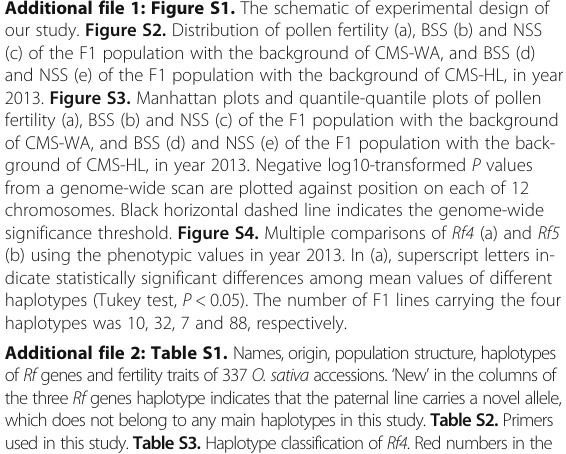
Additional file 1: Figure S1. The schematic of experimental design of our study. Figure S2. Distribution of pollen fertility (a), BSS (b) and NSS (c) of the F1 population with the background of CMS-WA, and BSS (d) and NSS (e) of the F1 population with the background of CMS-HL, in year 2013. Figure S3. Manhattan plots and quantile-quantile plots of pollen fertility (a), BSS (b) and NSS (c) of the F1 population with the background of CMS-WA, and BSS (d) and NSS (e) of the F1 population with the back- ground of CMS-HL, in year 2013. Negative log10-transformed P values from a genome-wide scan are plotted against position on each of 12 chromosomes. Black horizontal dashed line indicates the genome-wide significance threshold. Figure S4. Multiple comparisons of Rf4 (a) and Rf5 (b) using the phenotypic values in year 2013. In (a), superscript letters in- dicate statistically significant differences among mean values of different haplotypes (Tukey test, P < 0.05). The number of F1 lines carrying the four haplotypes was 10, 32, 7 and 88, respectively. Additional file 2: Table S1. Names, origin, population structure, haplotypes of Rf genes and fertility traits of 337 O. sativa accessions. ‘ New ’ in the columns of the three Rf genes haplotype indicates that the paternal line carries a novel allele, which does not belong to any main haplotypes in this study. Table S2. Primers used in this study. Table S3. Haplotype classification of Rf4 . Red numbers in the Position column indicate selected SNPs to differentiate different haplotypes in the partial sequencing of Rf4 . Table S4. Haplotype classification of Rf5 . Red numbers in the Position column indicate selected SNPs to differentiate different haplotypes in the partial sequencing of Rf5